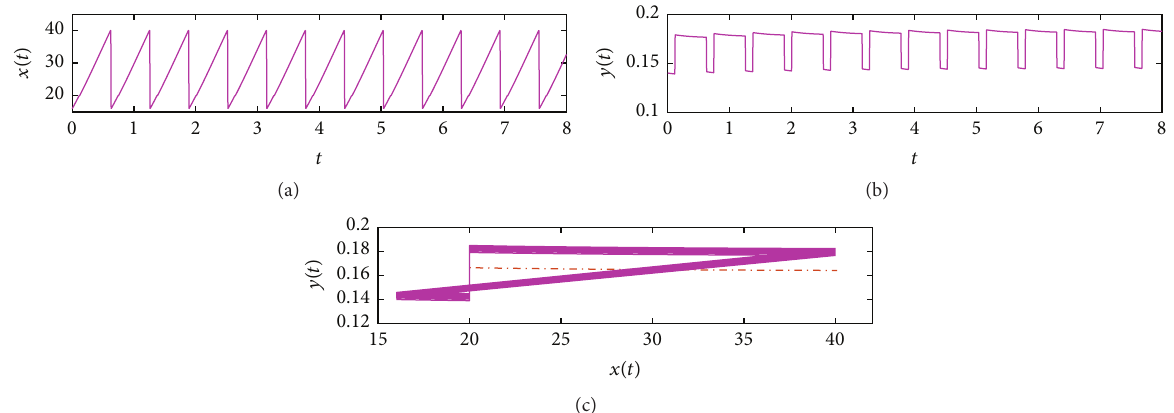
Figure 7: The change in prey density (a), predator density (b), and phase diagrams (c) starting from (𝑥 0 ,𝑦 0 ) = (16, 0.14) with 𝑝 = 0.6 , 𝑞 = 0.2 , = 20 , ℎ = 40 , 𝑦 (ℎ ) = 0.1664 , and 𝛼 ℎ 1 2 𝜏 1